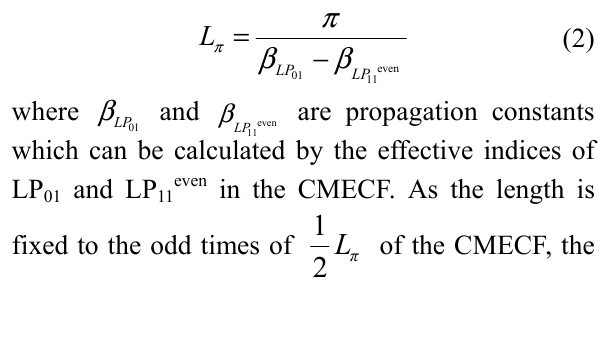
Fig. 4 Interference-pattern analysis: (a) excitation coefficients of guided modes in the CMECF, (b) transmission spectrum of the CSC structure, and (c) spatial frequency of the transmission